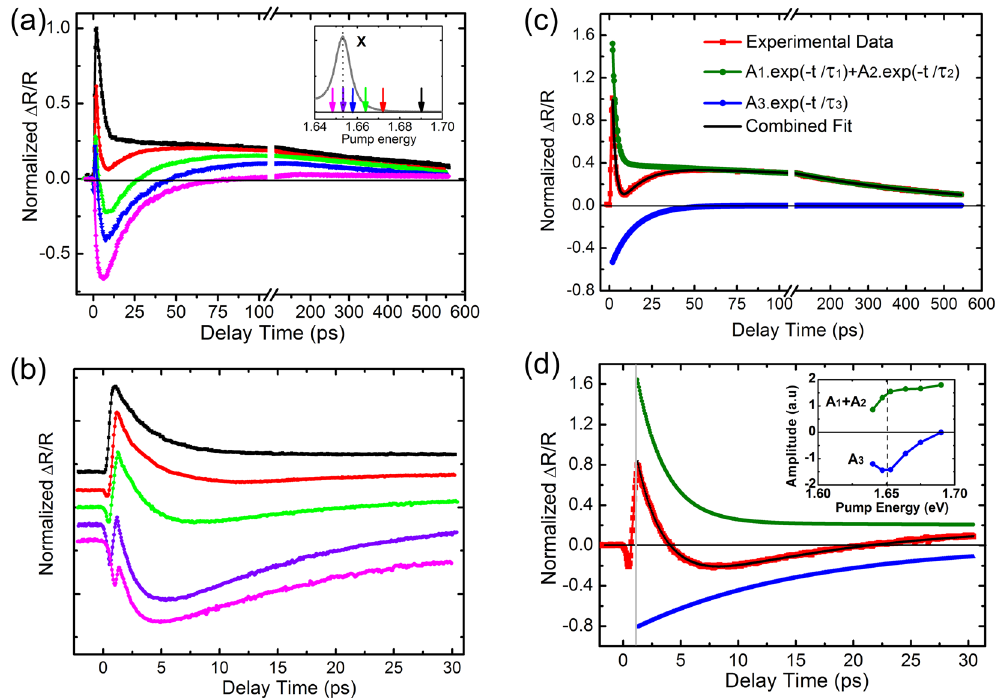
Figure 2. ( a ) Normalized transient reflectivity at different pump photon energies with the probe photon energy fixed at the trion resonance. The inset displays the corresponding pump energy near the exciton resonance. ( b ) The corresponding transient reflectivity within 30 ps measured with higher time-resolution. ( c ) and ( d ) The decay processes and the fit to the data obtained at the pump energy of 1.676 and 1.665 eV, respectively. The amplitudes of the positive ( A 1 + A 2 ) and negative ( A 3 ) components as a function of pump photon energy are shown in the inset of ( d